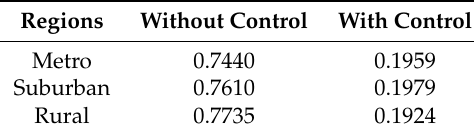
Figure 9. MRSA model simulation with no movement. ( a ) Infected individuals in large metro area, ( b ) Infected individuals in suburban area. ( c ) Infected individuals in rural area. Parameter values used are given in Tables 2–4. Table 8. Final population size when controlling MRSA when the regions are